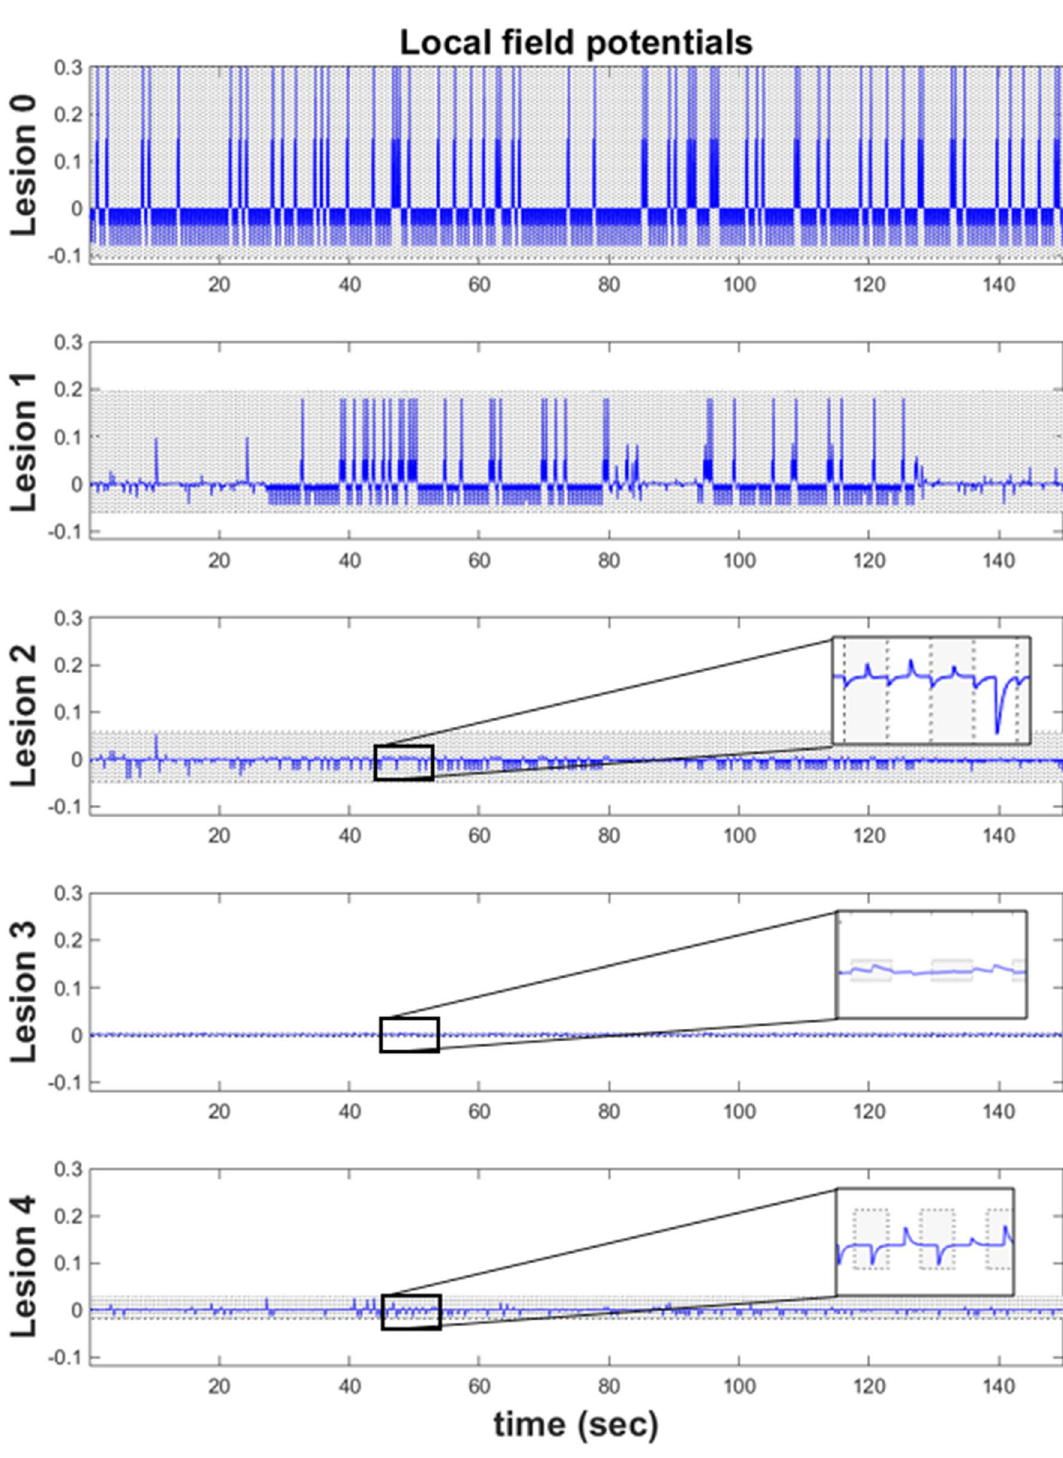
Figure 6. (Simulated local field potentials) These plots show the temporal changed in simulated local field potentials for the Target Word ‘table’ neuronal population across the first 300 trials, for a particular simulation. The blue line represents the trajectory of evoked responses for the Target Word ‘table’ over some arbitrary unites (y-axis). The simulated lesion models are presented in the following order: Lesion 0, Lesion 1, Lesion 2, Lesion 3 and Lesion